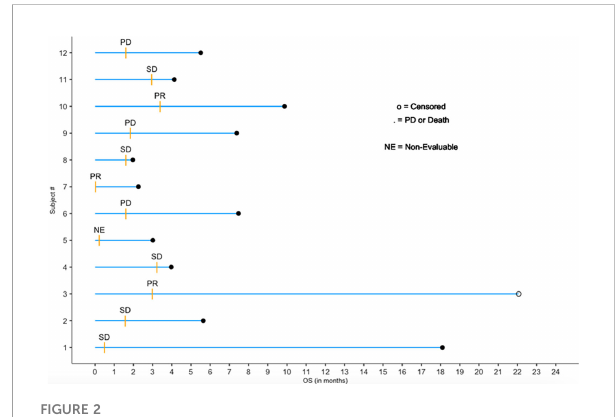
FIGURE 2 Follow-up swimmer plot by exposure months and response status.